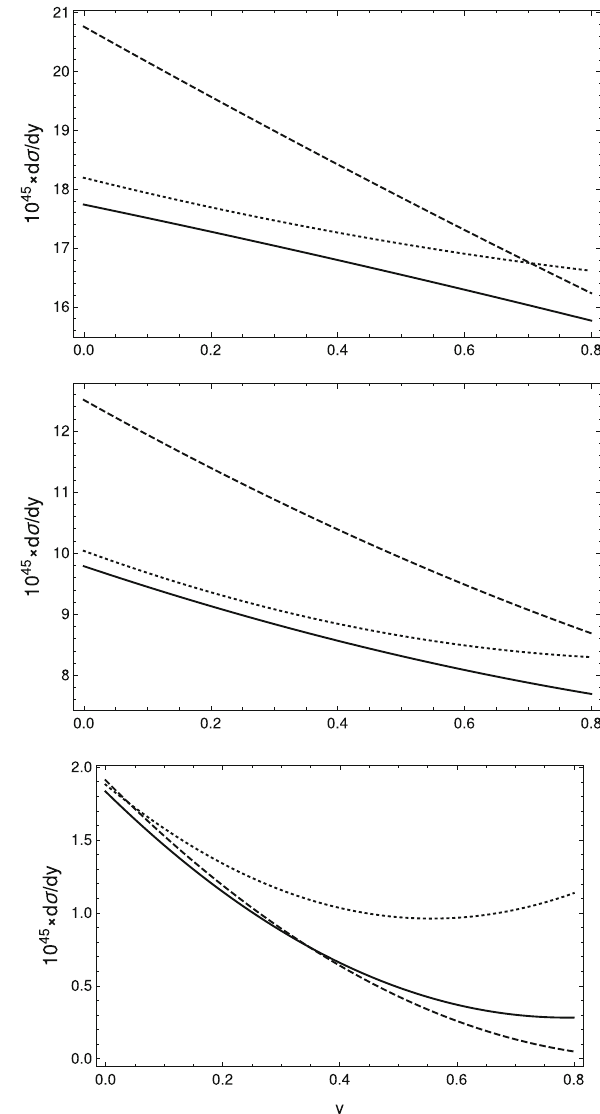
= π/ 2; lower plot for θ = π ; dashed line 1 1 | = 0 . 3 ,θ = 0; dotted line for T , R T | = 0 . 3 ,θ = 0; solid line for S , R S | = 0 . 3 ,θ = S , R S